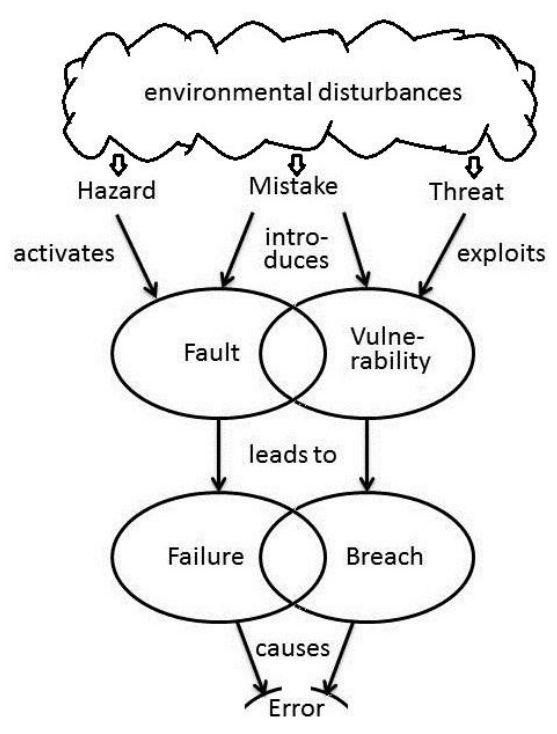
Figure 2. Impact and relationships of hazards and threats.